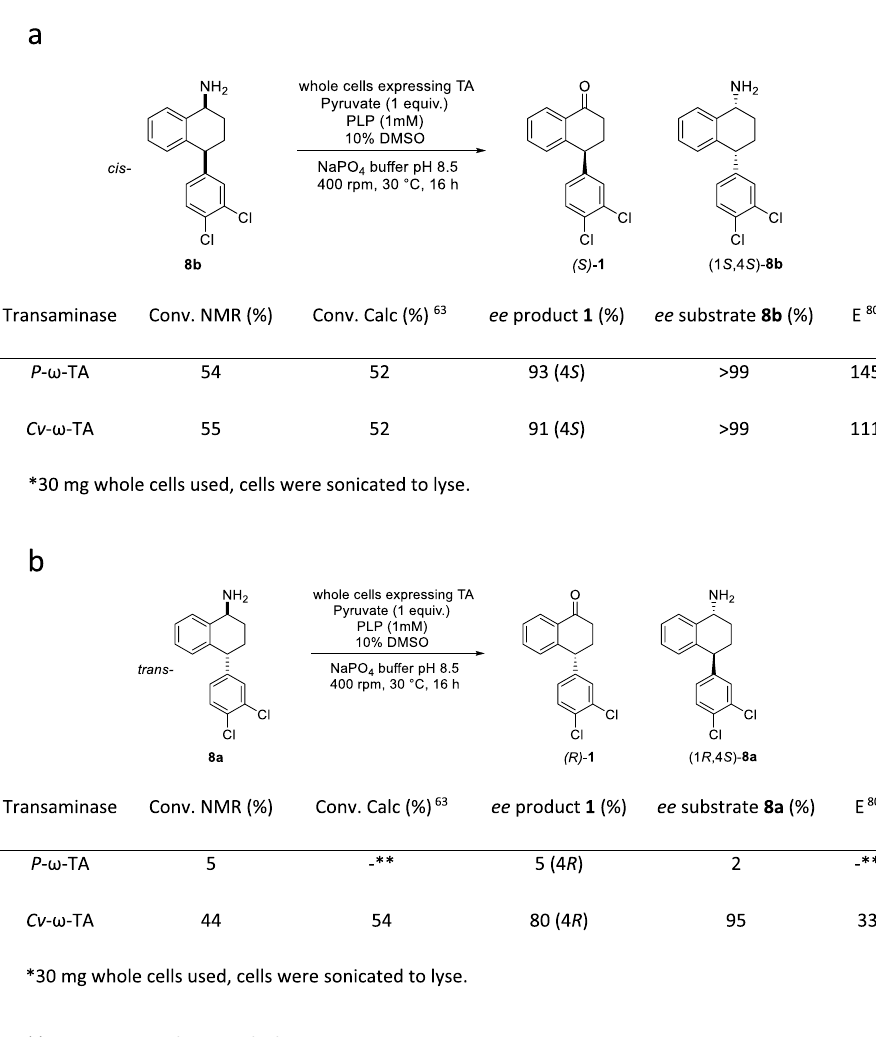
Figure 5. Activity of P -ω-TA and Cv -ω-TA against ( a ) cis -amine 8b and ( b ) trans -amine 8a . Data is from a representative experiment of three independent biological replicates with excellent